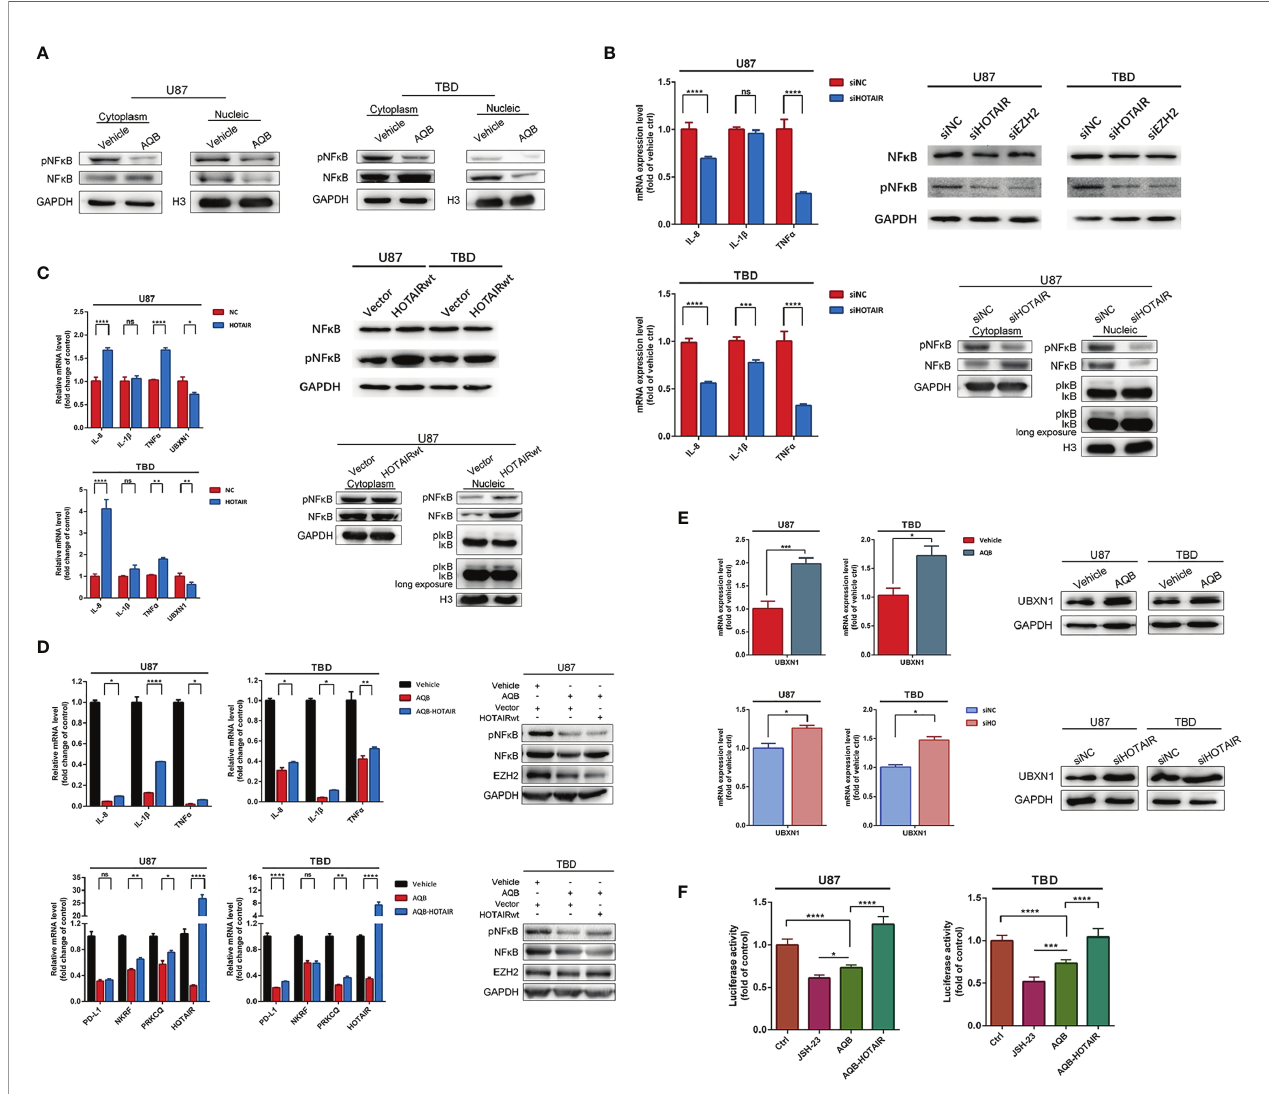
FIGURE 4 | Inhibition of H3K27me3 modi fi cation can regulate the activation and function of NF- k B. (A) Immunoblots showing the distribution of NF- k B and pNF- k B proteins in the nucleus and cytoplasm, with GAPDH as the cytoplasmic protein control and histone H3 as the nuclear protein control. (B) Quantitative PCR to detect mRNA expression levels of IL-8, IL-1 b , and TNF a in U87 and TBD cells treated with HOTAIR knockdown. The protein expression levels of NF- k B and pNF- k B in U87 and TBD cells with HOTAIR knockdown and EZH2 knockdown were detected by immunoblots. (C) Quantitative PCR to detect mRNA expression levels of IL-8, IL-1 b , TNF a and UBXN1 in U87 and TBD cells overexpressing HOTAIR. Immunoblots detected the protein expression levels of NF- k B and pNF- k B in U87 and TBD cells overexpressing HOTAIR. (D) Quantitative PCR detecting mRNA expression levels of IL-8, IL-1 b , TNF a , PD-L1, NKRF, PRKCQ and HOTAIR in U87 and TBD cells treated with AQB or AQB deals with joint HOTAIR overexpression. Immunoblots detected the protein expression levels of NF- k B and pNF- k B in U87 and TBD cells treated with AQB or AQB deals with joint HOTAIR overexpression. (E) Quantitative PCR and immunoblots showing the message RNA and protein level of UBXN1 in U87 and TBD cells treated with AQB using vehicle as control. (F) NF k B function was analysis using NF k B binding domain fused luciferase reporter vector in U87 and TBD cells treated with JSH-23, or AQB or AQB joint HOTAIR overexpression. For all the statistical histograms above, values are means±s.d. from n=3 independent experiments. The P value was determined by two-sided Student ’ s t-test. ns, not statistically signi fi cant, * P < 0.05, ** P < 0.01, *** P < 0.001, **** P <